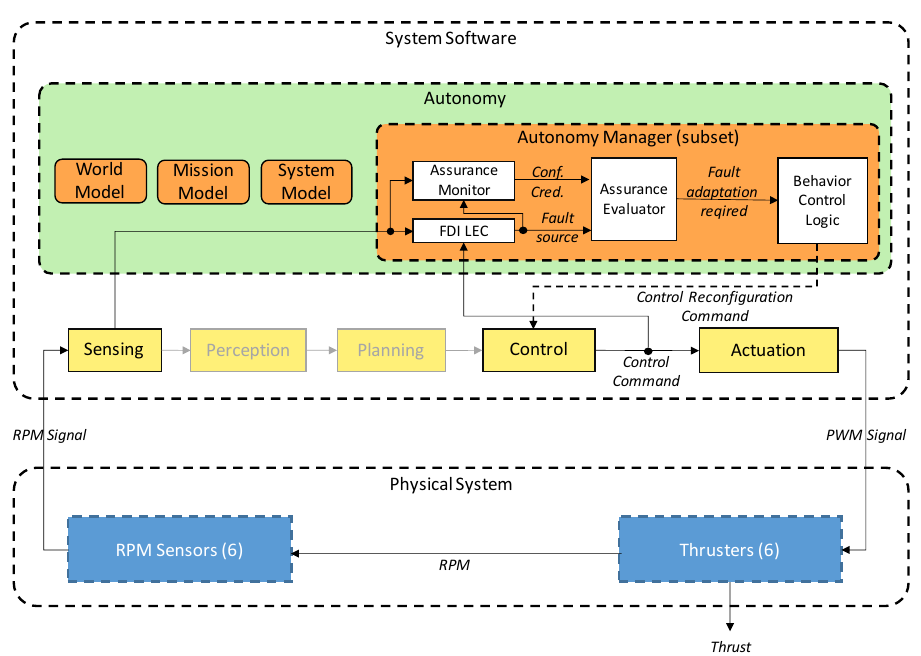
Figure 2. Detailed system architecture—focusing on the Autonomy